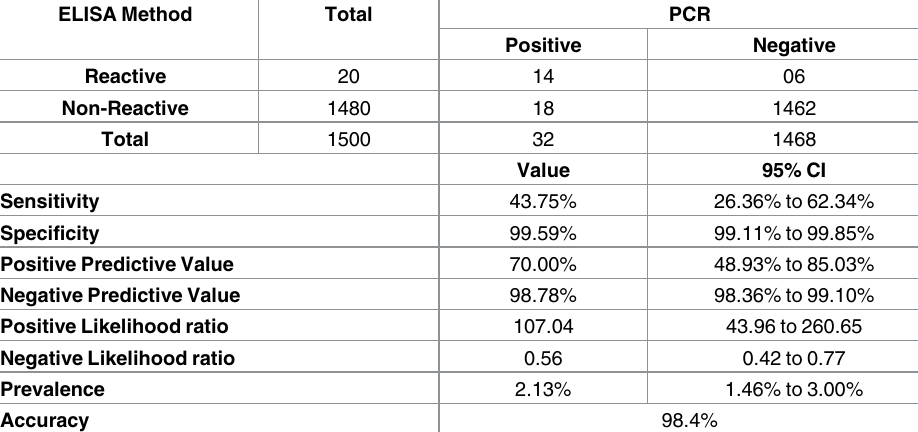
Table 2. Overall results of ELISA (n =